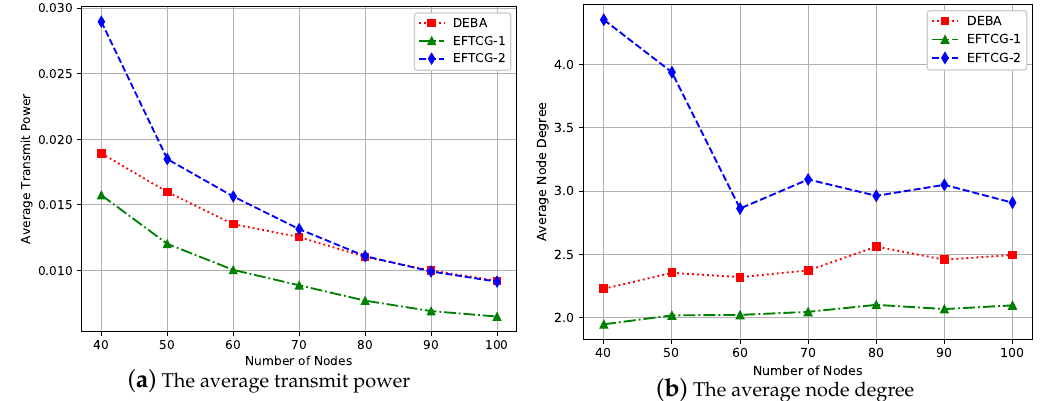
Figure 11. The average transmit power and the average node degree, ( a ) the change of the average transmit power; ( b ) the change of the average node degree.